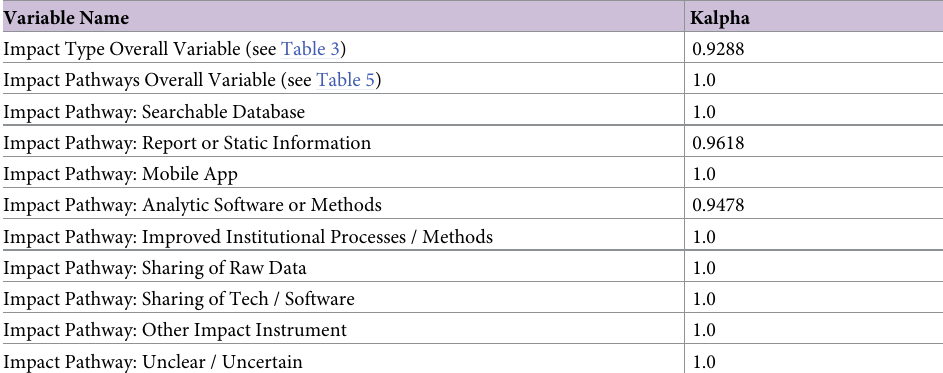
Table 2. Krippendorff’s alpha for variables analysed in this study.